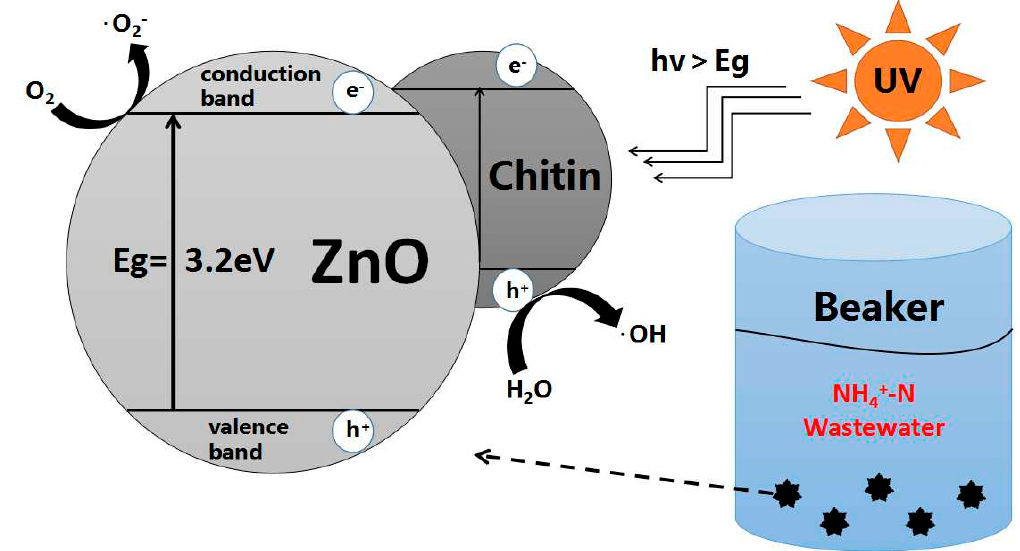
Figure 1. The interaction mechanism of the chitin/ZnO composite photocatalyst.